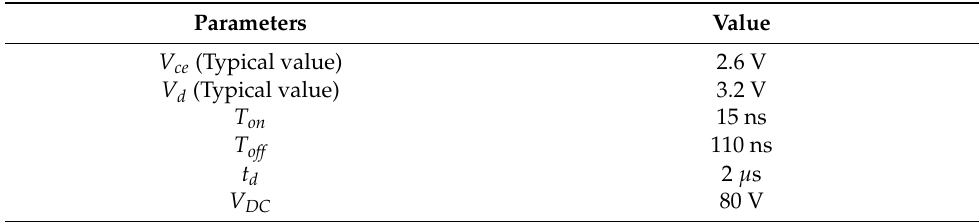
Table 2. Parameters of